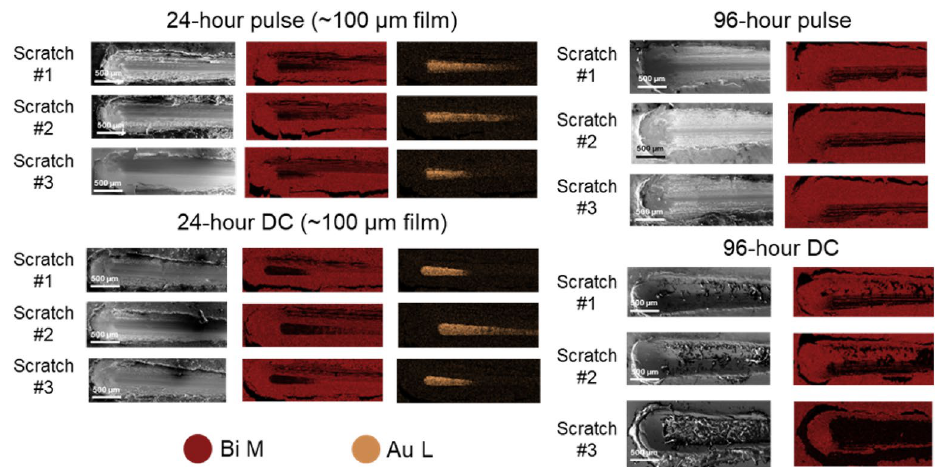
Figure 8. EDS maps of pulse-plated Bi films showing film breakthrough on ~ 100 µm 24-h samples, but not 96-h samples. Maps were made using Bi M lines and Au M